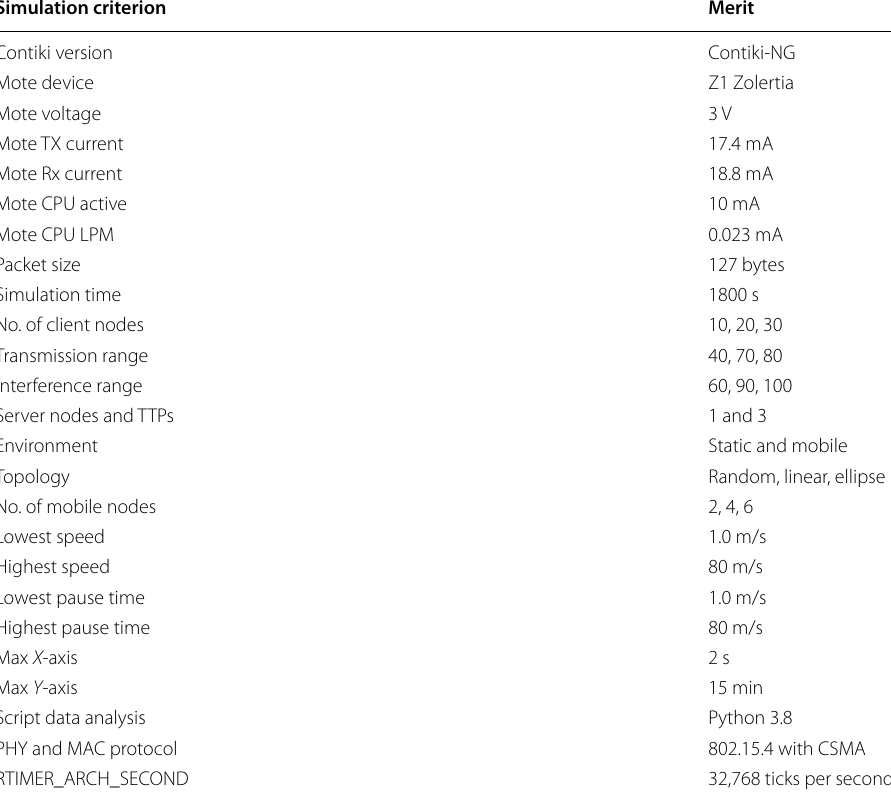
Table 2 Simulation criterion and merit Simulation